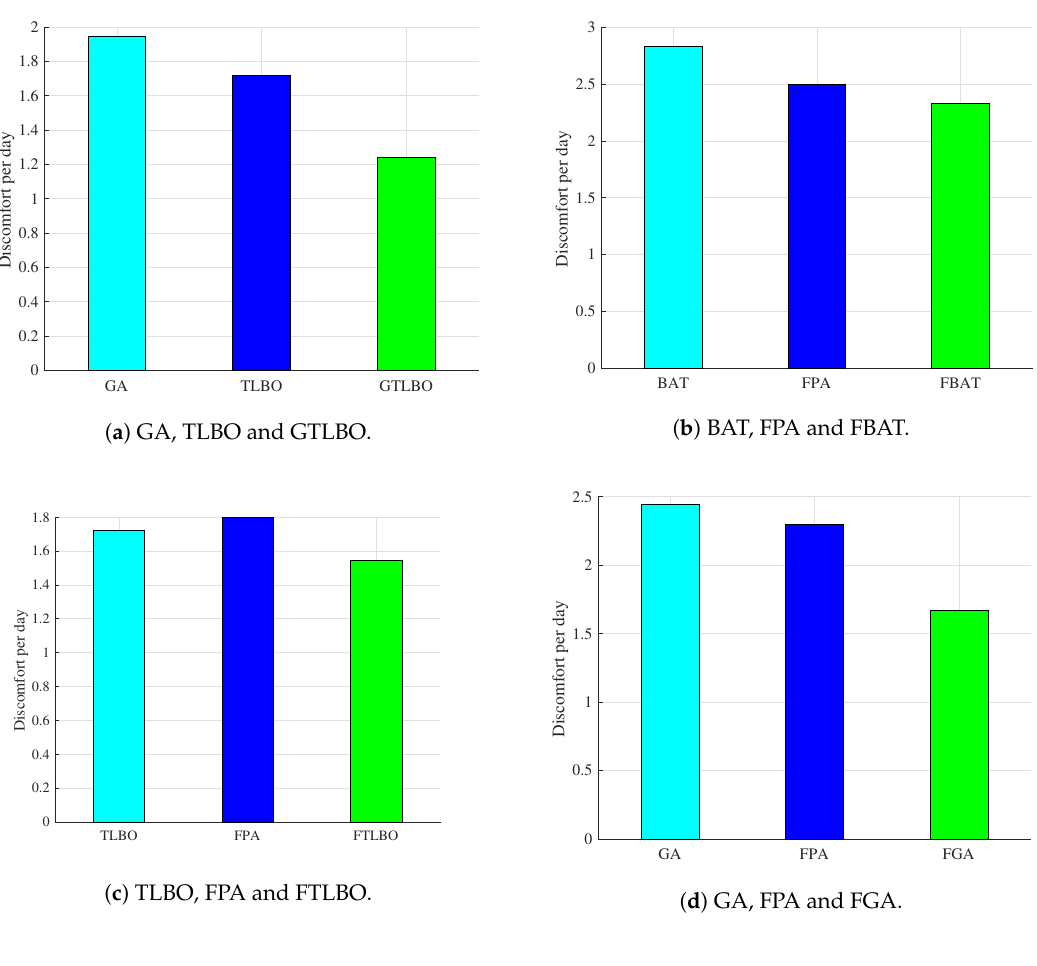
Figure 10. Daily discomfort of appliances.